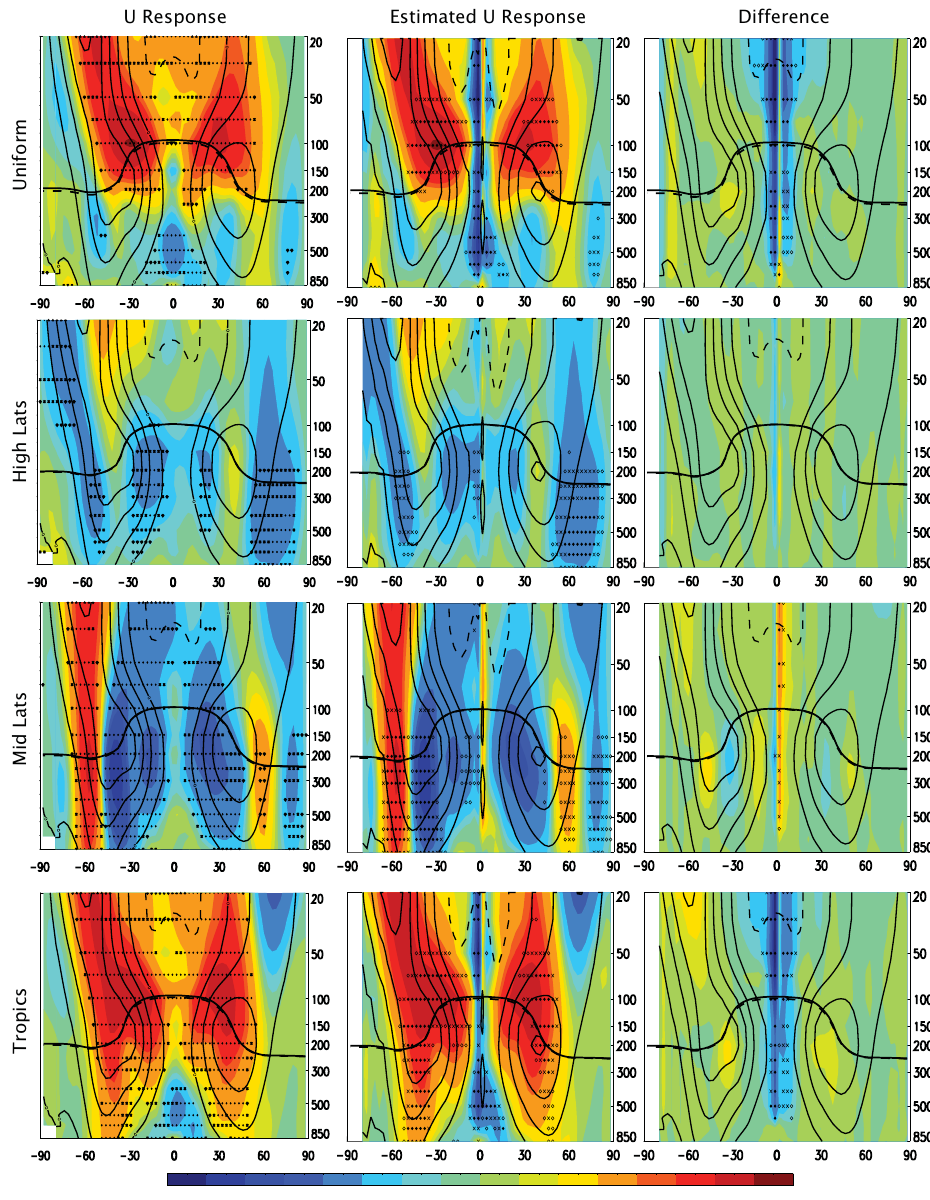
Fig. 5. Zonal annual mean zonal wind response (left), estimated zonal wind response (center) and difference (estimate-actual; right) for the lower-tropospheric heating experiments. The estimated U response is based on thermal wind balance, using the 900hPa winds as a lower boundary condition. Also shown is the tropopause pressure for the (dashed) control and (solid) experiment. Symbols represent significance at the 90% (diamond); 95% (cross) and 99% (dot) confidence level. Climatological U contour interval is 10 m s − 1 with negative values dashed. Left panels ( U response) are as in Fig.